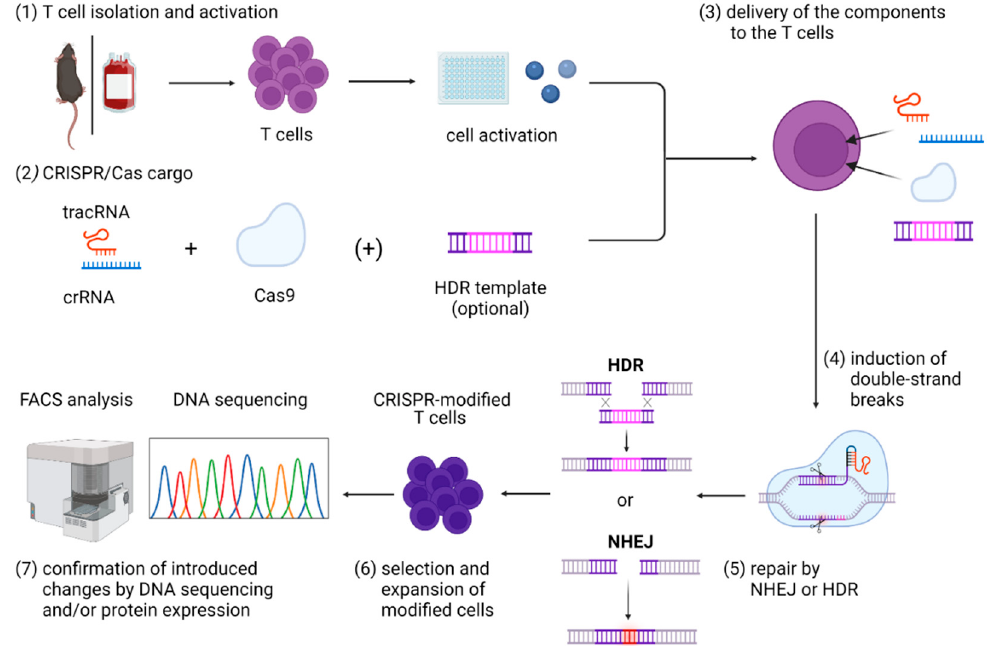
Figure 1. Graphical overview of steps included in the CRISPR/Cas9 gene editing in primary T cells, including (1) T-cell isolation and activation; (2) in vitro assembly of CRISPR/Cas cargo; (3) its deliv- ery to the T cells; (4) induction of double-strand breaks that can be (5) repaired mainly by NHEJ or HDR; and (6) expansion and selection of modified cells and (7) confirmation of introduced changes by DNA sequencing and/or protein expression. Abbreviations: Cas9—CRISPR-associated protein 9; crRNA—CRISPR RNA; HDR—homology-directed repair; NHEJ—non-homologous end joining; tracrRNA—trans-activating CRISPR RNA. Figure created with